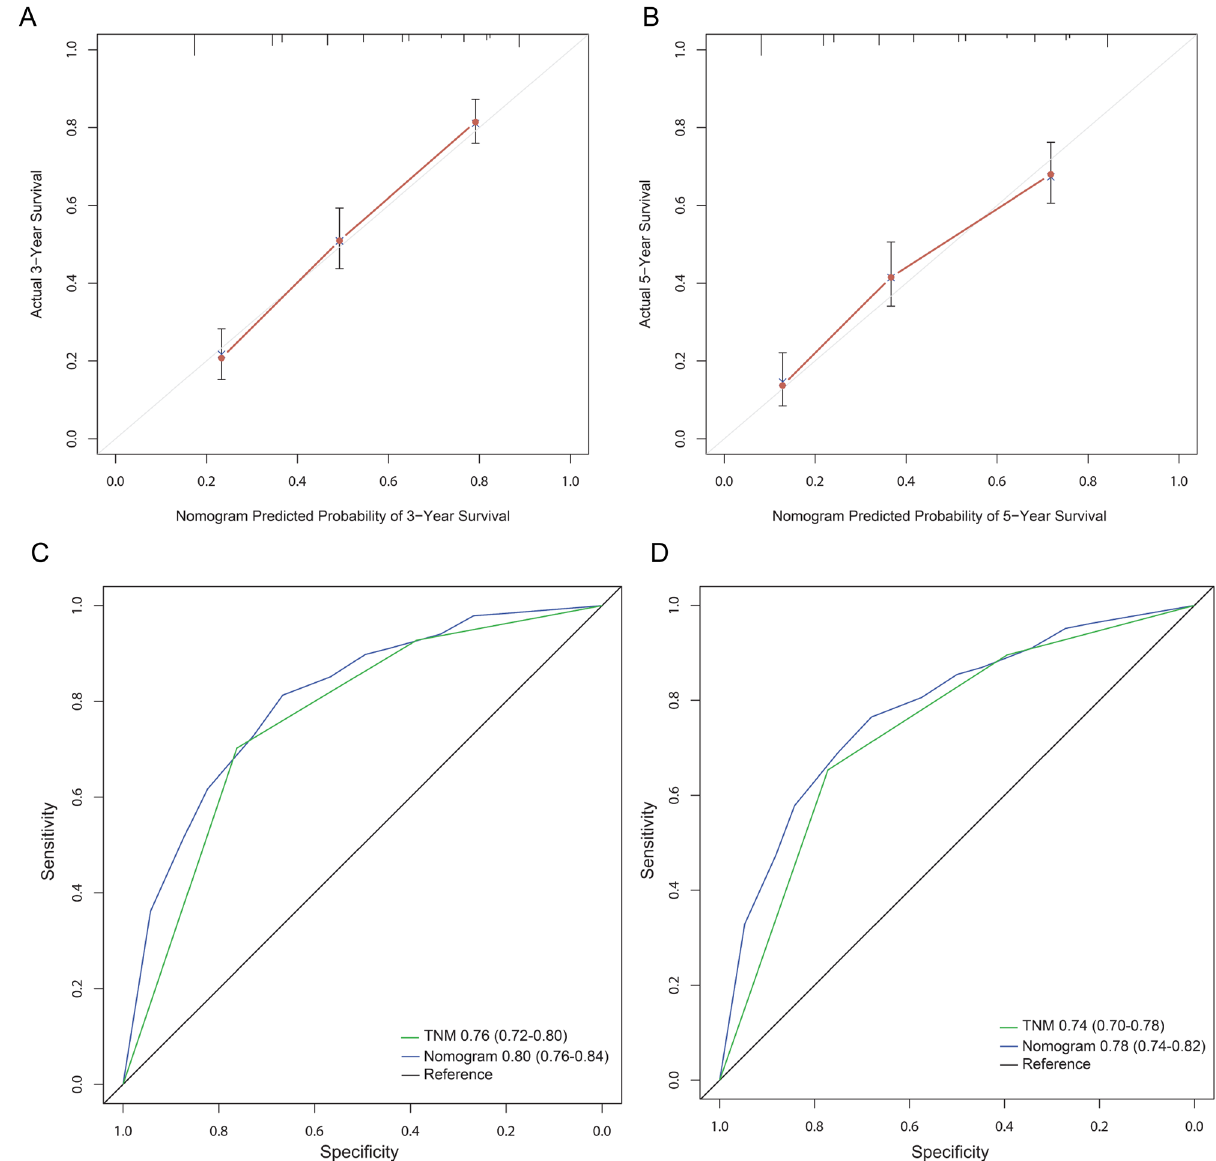
Figure 4. The 3-year ( A ) or 5-year ( B ) survival rate of resectable gastric cancer patients predicted by nomogram is highly consistent with the actual observed values in the primary cohort. The ability of ROC analysis nomogram to predict the 3-year ( C ) or 5-year ( D ) survival rate of resectable gastric cancer patients, the nomogram has a larger AUC than TNM staging in the primary